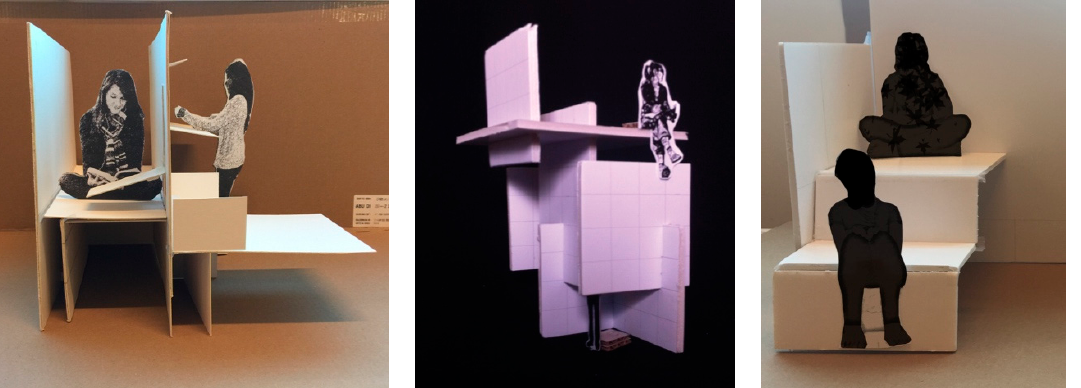
Figure 13. Mapping activities through set periods of time. Movement representation. Work sample from Project Part I. Courtesy of Mariam Al Nuaimi and Alaa Al Hashemi.